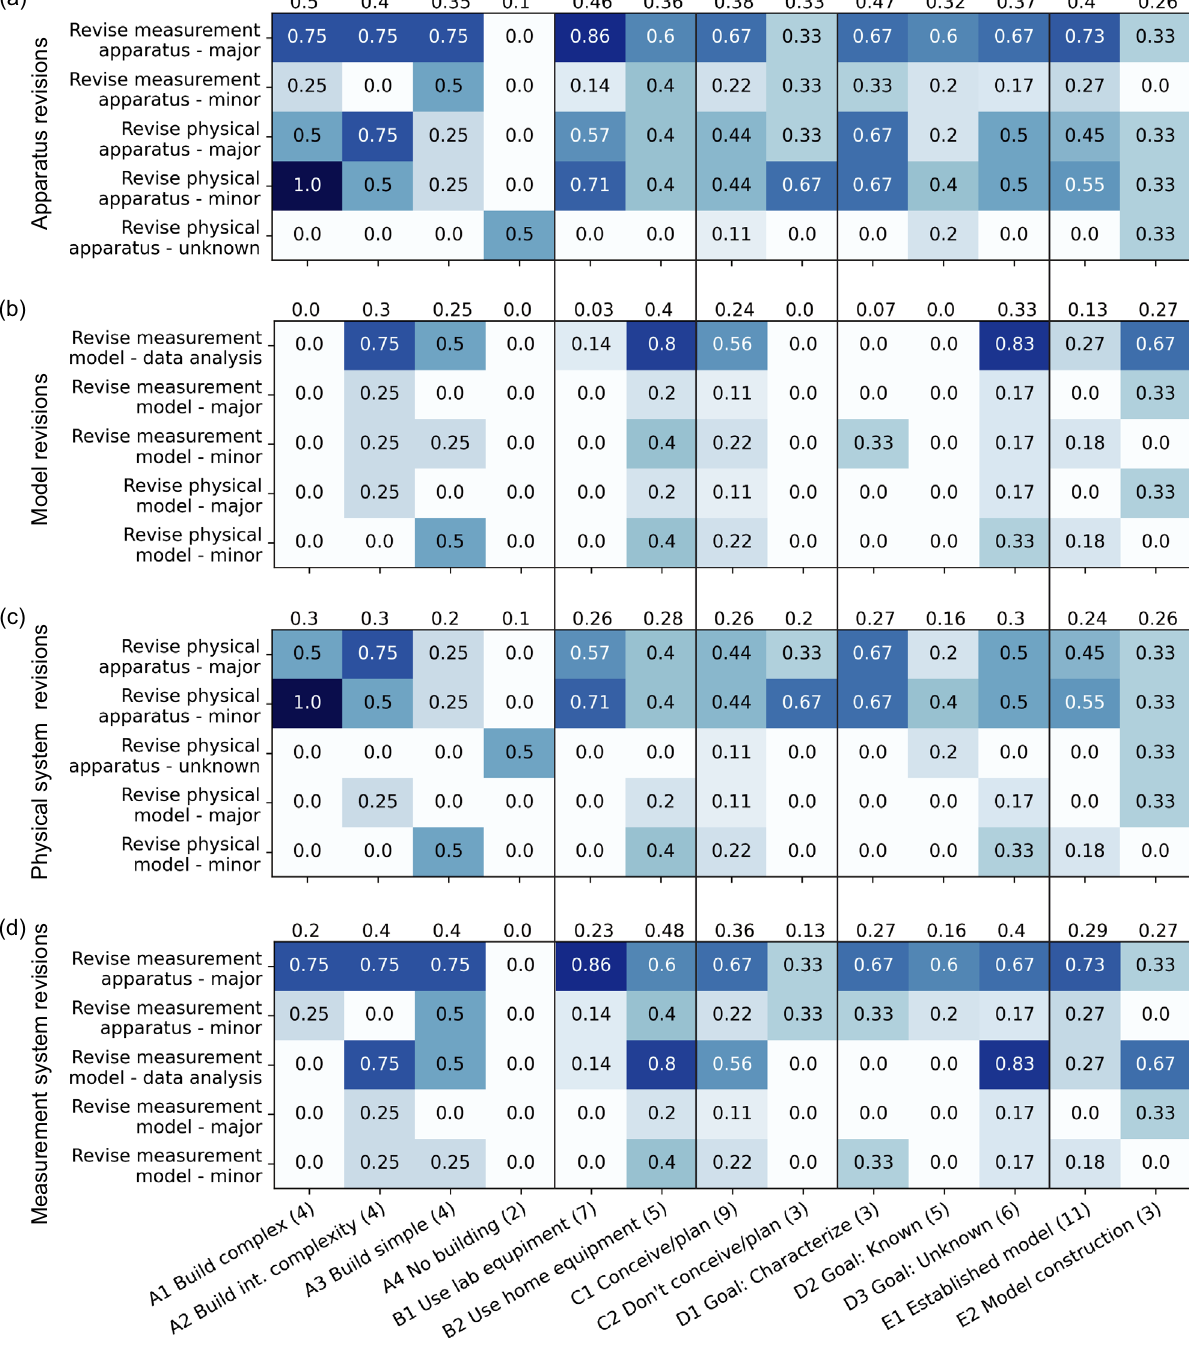
FIG. 6. Fraction of projects with a specified feature (columns, organized by category) assigned the enact revisions subcodes (rows) for (a) apparatus revisions, (b) model revisions, (c) physical system revisions, and (d) measurement system revisions. The numbers in parentheses following the abbreviated feature names are the number of projects with each feature, and the numbers on top are averages over each column. For each of the subplots, the features with the largest column averages can be interpreted as being most associated with that category of